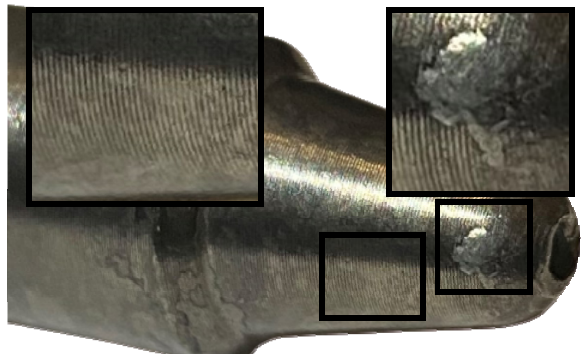
Figure 21. Feed marks impact on nucleation and propagation of premature